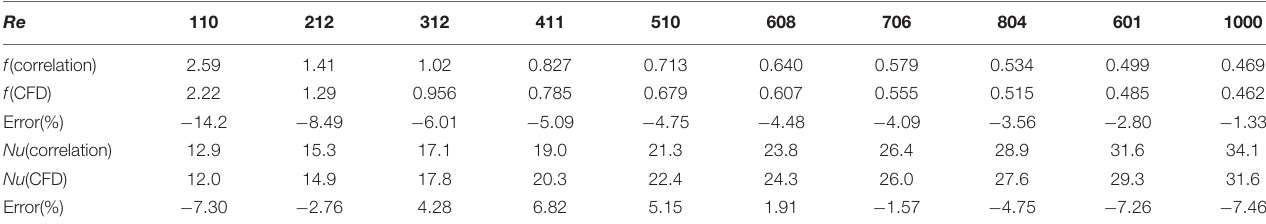
TABLE 2 | Comparison of the CFD results with empirical correlation (Manglik and Bergles,